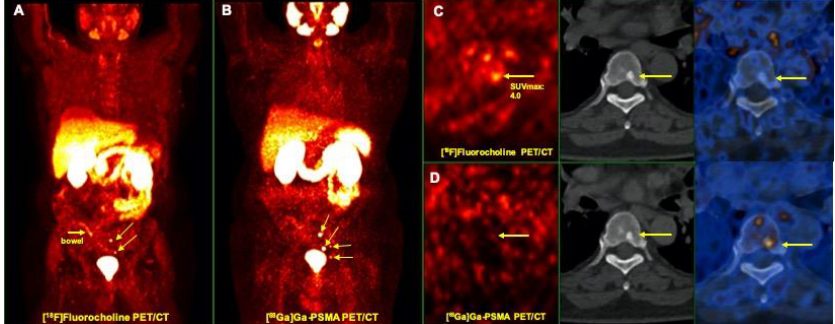
Figure 5. Prostate cancer recurrence: small skeletal metastases exclusively detected by [ 18 F]Fluorocholine PET/CT. ( A ) [ 18 F]Fluorocholine PET: MIP shows two small lymph nodes on the left pelvis suggestive of lymph node metastases (arrows). ( B ) [ 68 Ga]Ga-PSMA PET/CT: MIP shows multiple intensive [ 68 Ga]Ga-PSMA positive pelvic lymph nodes, clearly superior to [ 18 F]Fluorocholine PET/CT (arrows). ( C ) [ 18 F]Fluorocholine PET/CT (transaxial PET (left), CT (middle) and fusion PET/CT (right) images) exclusively detected a single bone metastasis on T6 vertebra well correlating with suspicious sclerosis on CT (arrows). ( D ) [ 68 Ga]Ga-PSMA PET/CT (transaxial PET (left), CT (middle) and fusion PET / CT (right) images) shows limited value for detecting bone metastasis on T6 vertebra in spite of its superiority for detecting lymph node